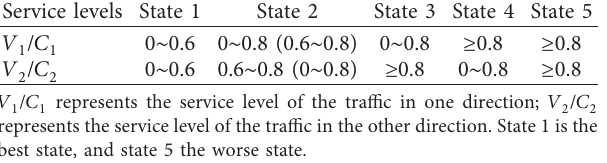
Table 1: Road conditions and corresponding service levels. Service levels State